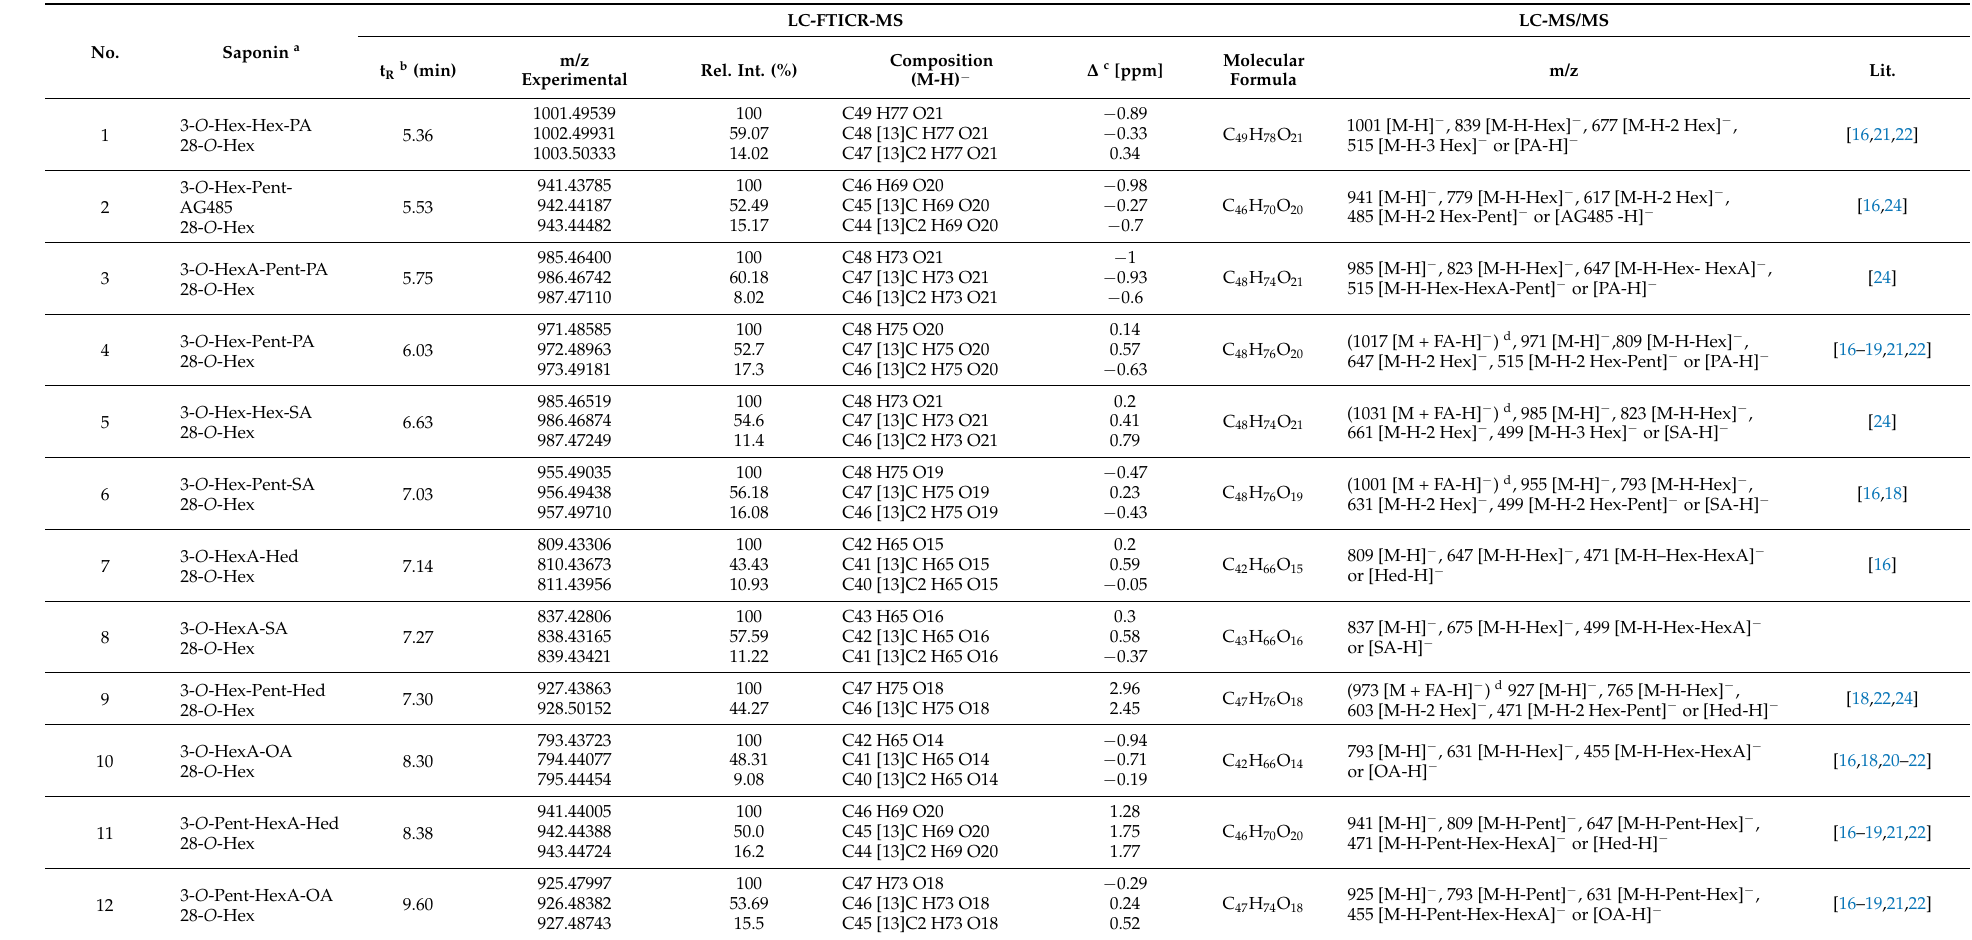
Table 2. Existing triterpenoid saponins from seeds of C. quinoa accession